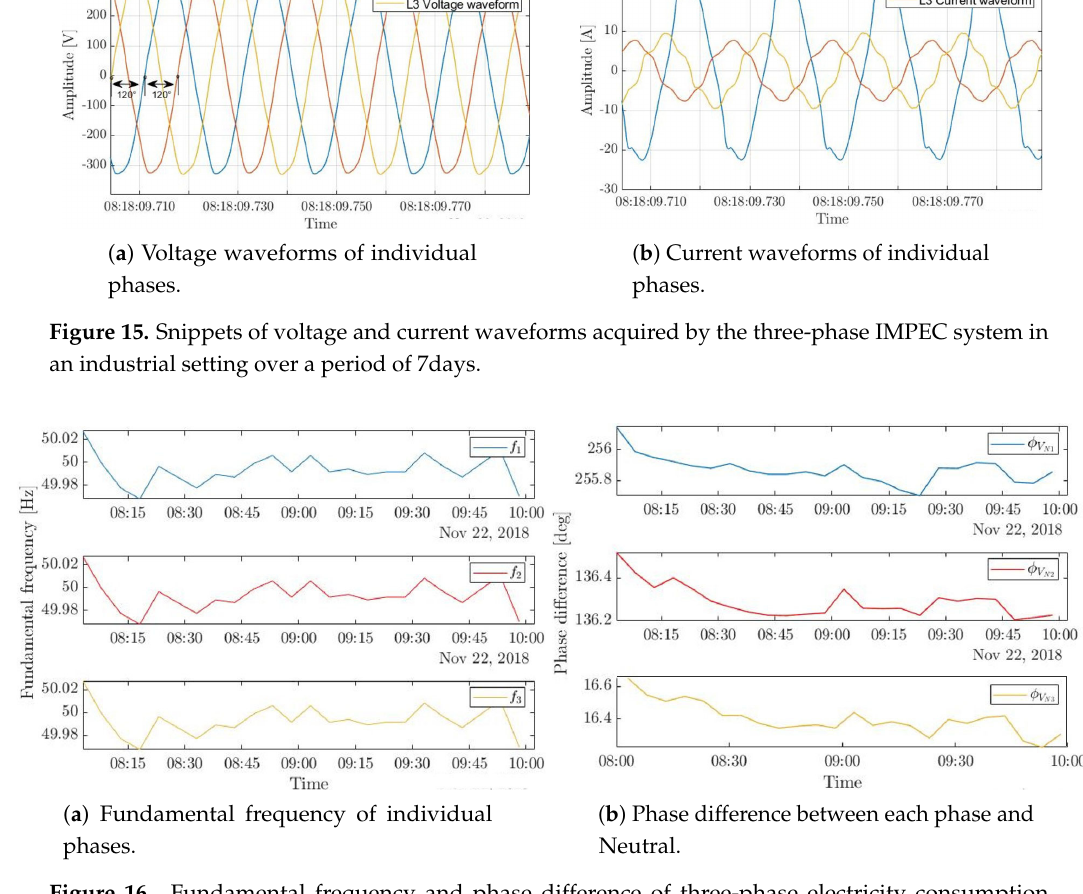
Figure 16. Fundamental frequency and phase difference of three-phase electricity consumption computed over a sliding window of five